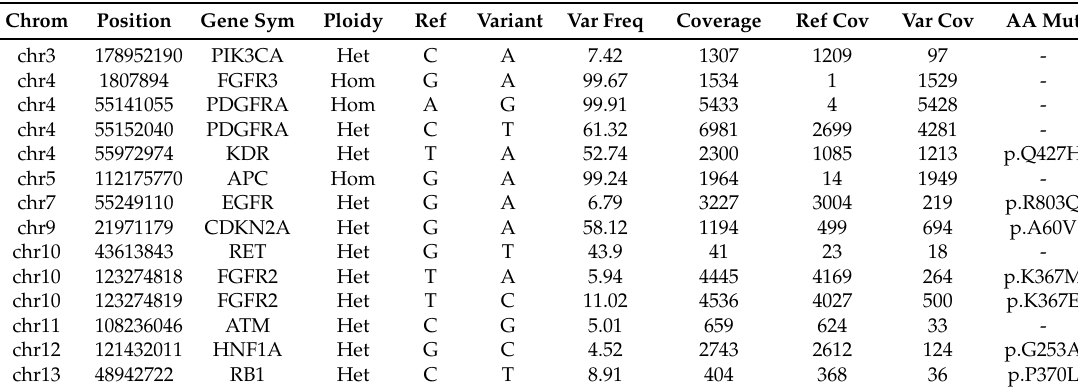
Table 3. Target variants of high-risk cSCC no. 2